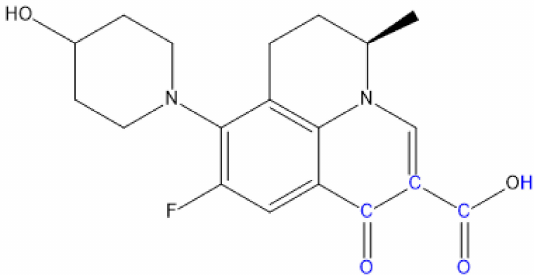
Figure 1. Template molecule NAD and its common